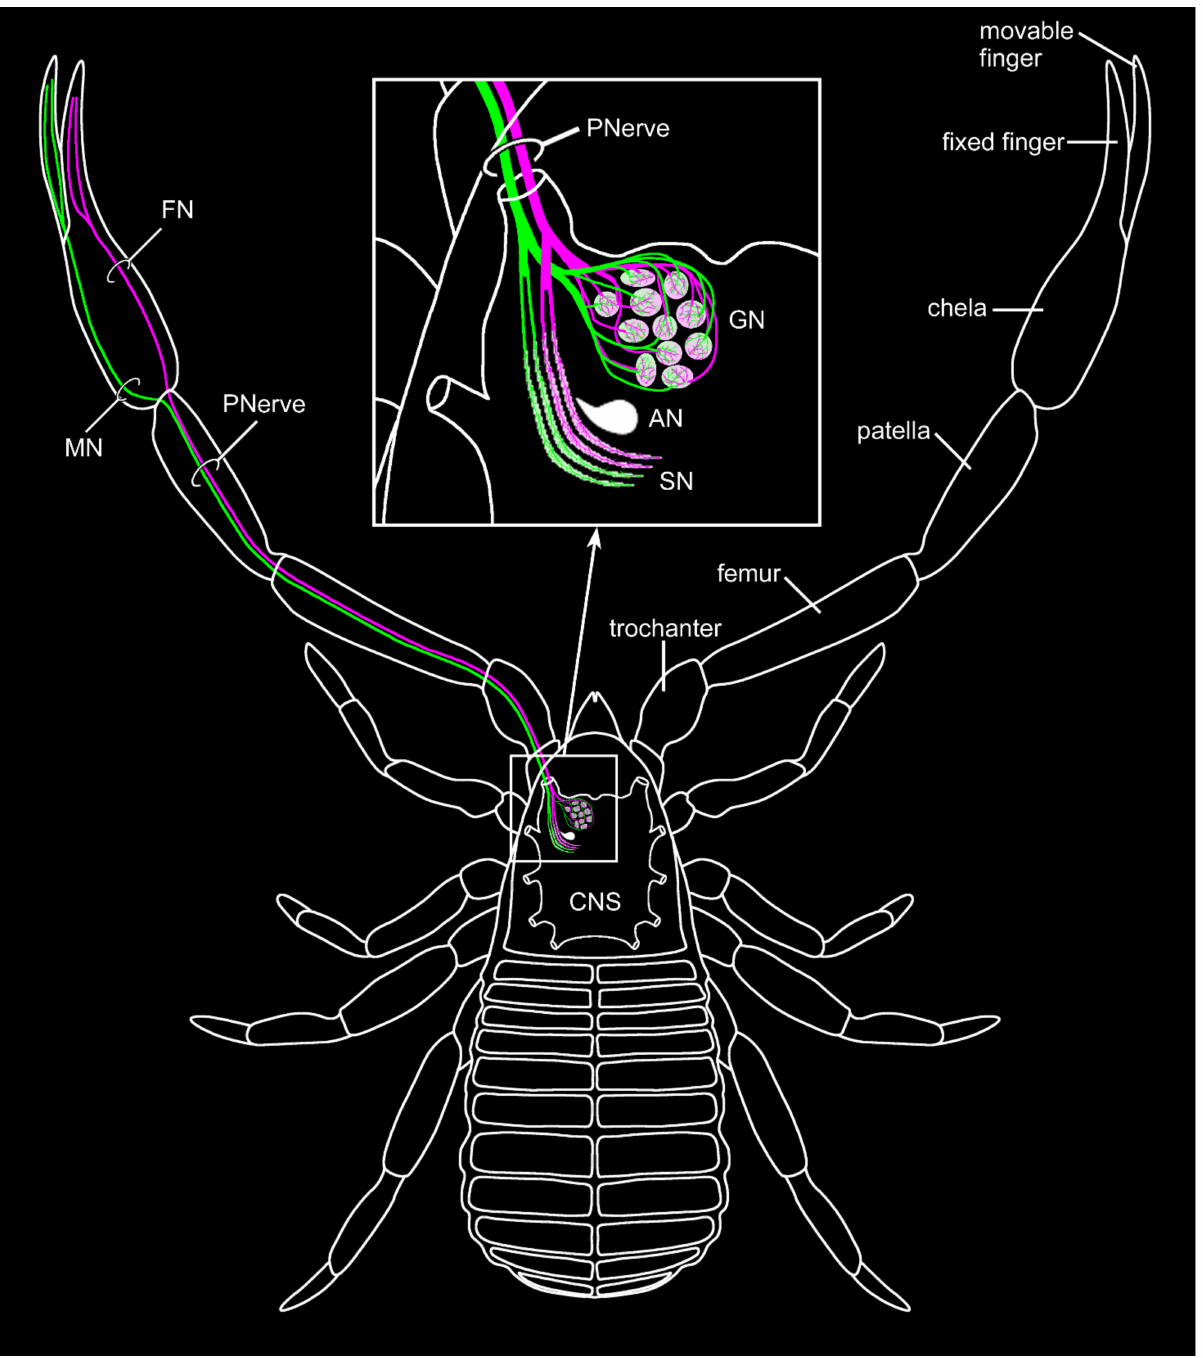
Figure 7. Schematic summary of the projection pattern of the sensory structures associated with the pedipalpal chelae of Chelifer cancroides . Differential labeling of afferents of the fixed (FN: fixed finger nerve, magenta) and movable finger (MN: movable finger nerve, green) innervate two neuropils in the pedipalpal neuromere within the central nervous system (CNS): The glomerular neuropil (GN) is innervated rather homogenously by projections from both fingers, while the stratified neuropil (SN) shows a clear separation in an anterior portion innervated by afferents from the fixed finger and a posterior portion innervated by fibers associated with the movable finger. Other abbreviations: AN: accessory neuropil; PNerve: pedipalpal